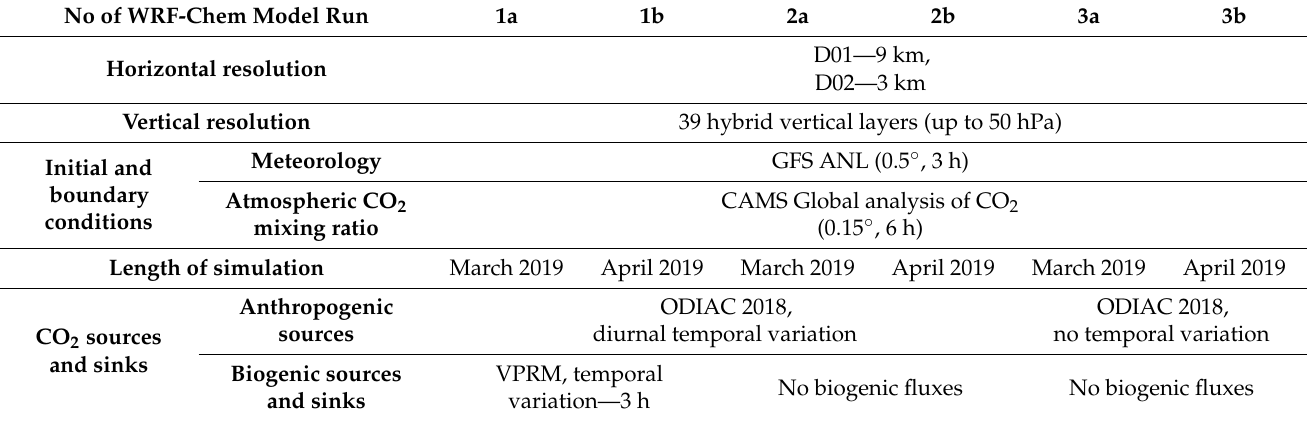
Table 1. The main characteristics of the Weather Research and Forecasting—Chemistry (WRF-Chem) runs. No of WRF-Chem Model Run 1a